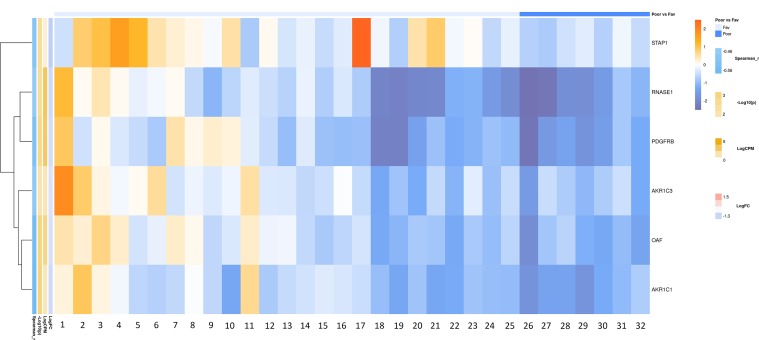
Heatmap demonstrating log relative expression level of top differentially expressed genes between the groups of adverse and favorable prognosis (Russian patient cohort). Cell colors (blue-white-orange gradient) correspond the binary logarithm of the ratio of the expression level in a current sample to the average level across all the samples (per each gene). Blue - expression level is below the average, orange - above the average. Spearman_r—Spearman’s rank correlation coefficient. -Log10(p) is the negative logarithm of DESeq’s p-value. LogCPM—average binary logarithm of read counts per million (CPM). LogFC—binary logarithm of expression-level fold change (sample with adverse prognosis compared to favorable prognosis).